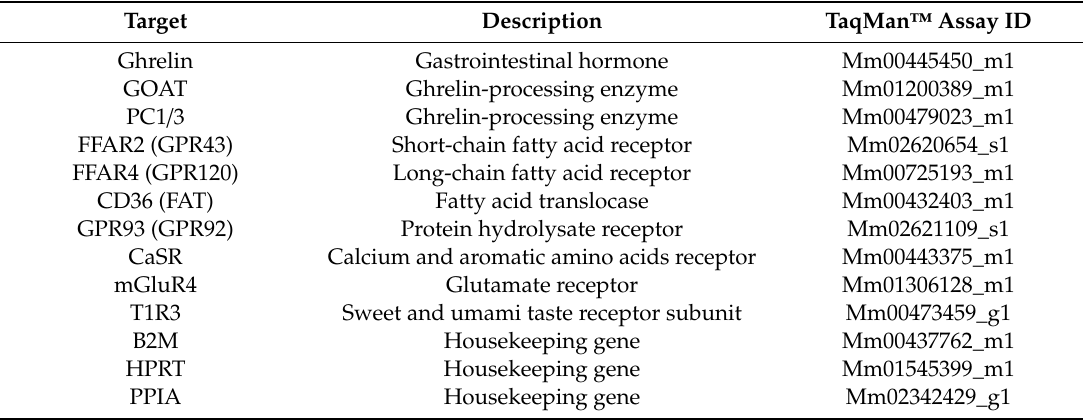
Table 1. Description and product code of qRT-PCR